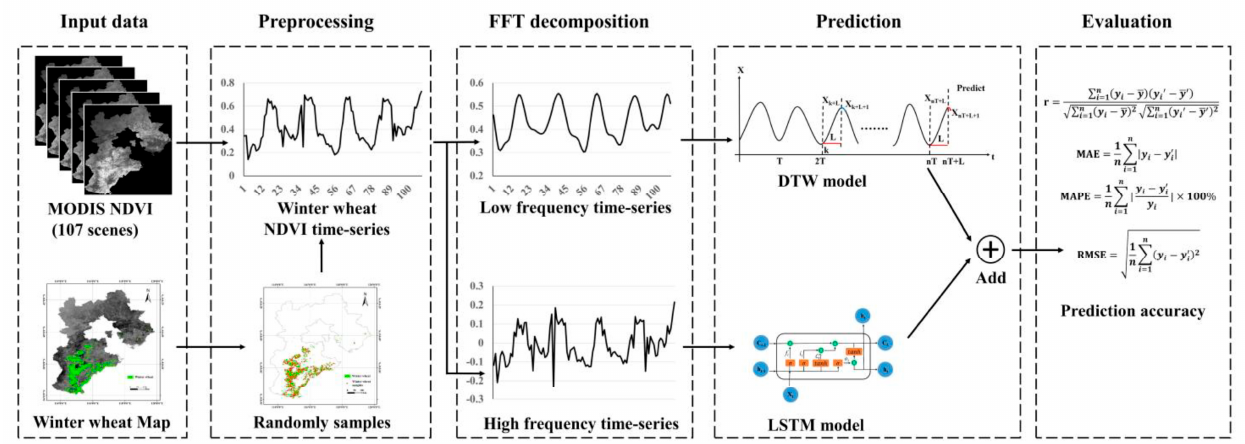
Figure 2. Workflow of the proposed DTW–LSTM combination method.